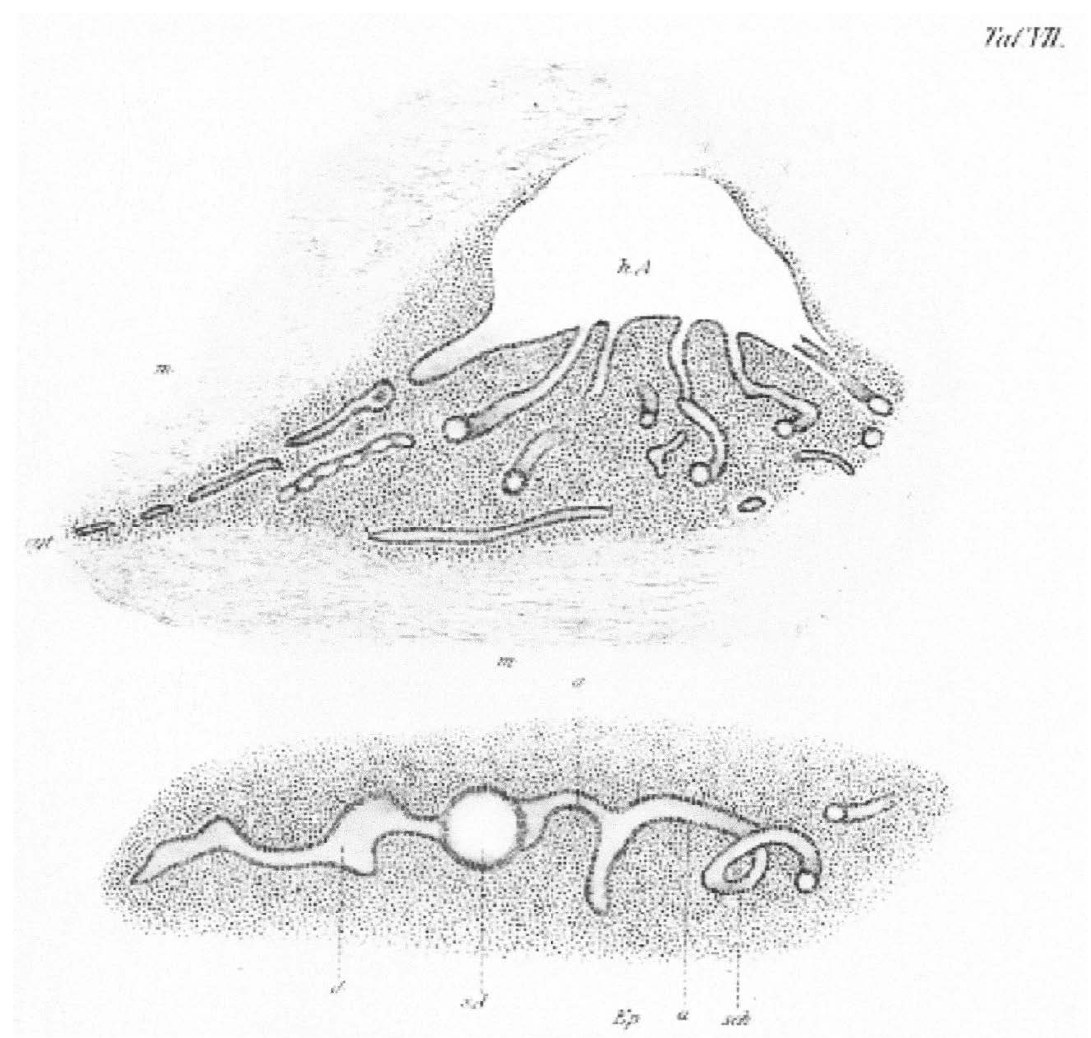
Figure 2. Example from von Recklinghausen’s (1896) histological study of uterine adenomyosis which he viewed as having similarities to the Wolffian duct structures. In the ( top ) von Recklinghausen demonstrates a main ampoule (hA) with raised and flattened epithelium on its roof and where the cytogenic connective tissue is completely lost. He views the six small canals at the bottom of the ampoule as probably collecting tubes with a leading canal on the left continuing in two fragments. He draws similarities to a collecting system. The ( bottom ) is viewed to depict a secretion tube (d) running from the left to connect to the spherical ampoule (sA) seen in the transverse section. This is seen to merge into the short collecting tube (a) running from the right and forming a looped section (sch).